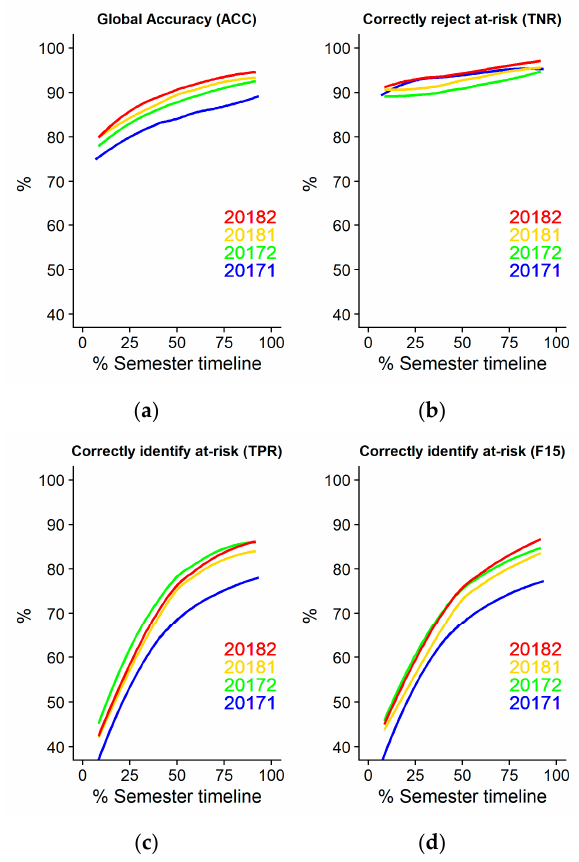
Figure 2. LOESS regression plots of the GAR model using Naive Bayes Classifier for ( a ) Accuracy, ( b ) TNR, ( c ) TPR, and ( d ) F-score 1,5 metrics from 20171 to 20182 semesters.